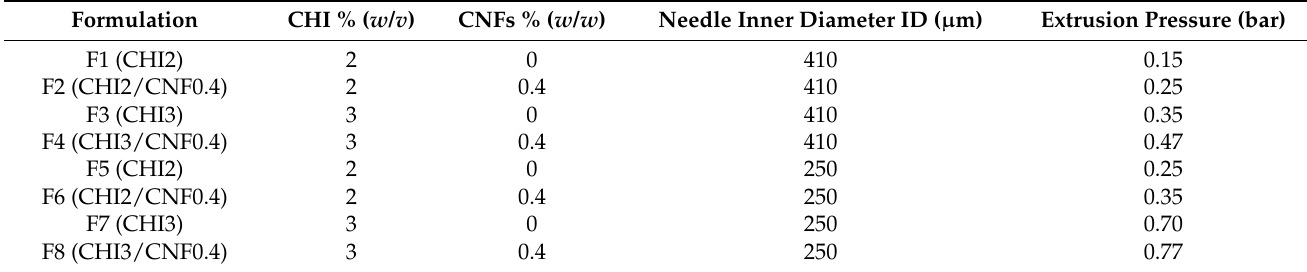
Table 1. Processing parameters for the printing of hydrogel filaments and 3D hydrogel scaffolds of CHI/CNF formulations.